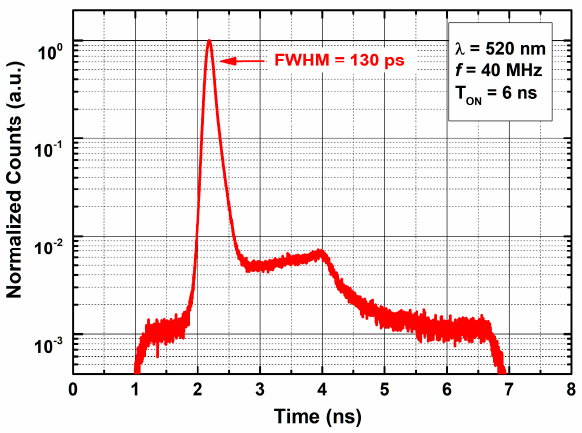
Figure 10. SPAD 1 response to a 113 ps (FWHM) at 520 nm when operated with a 6 ns gate at 40 MHz repetition rate. The curve is normalized to its main peak.